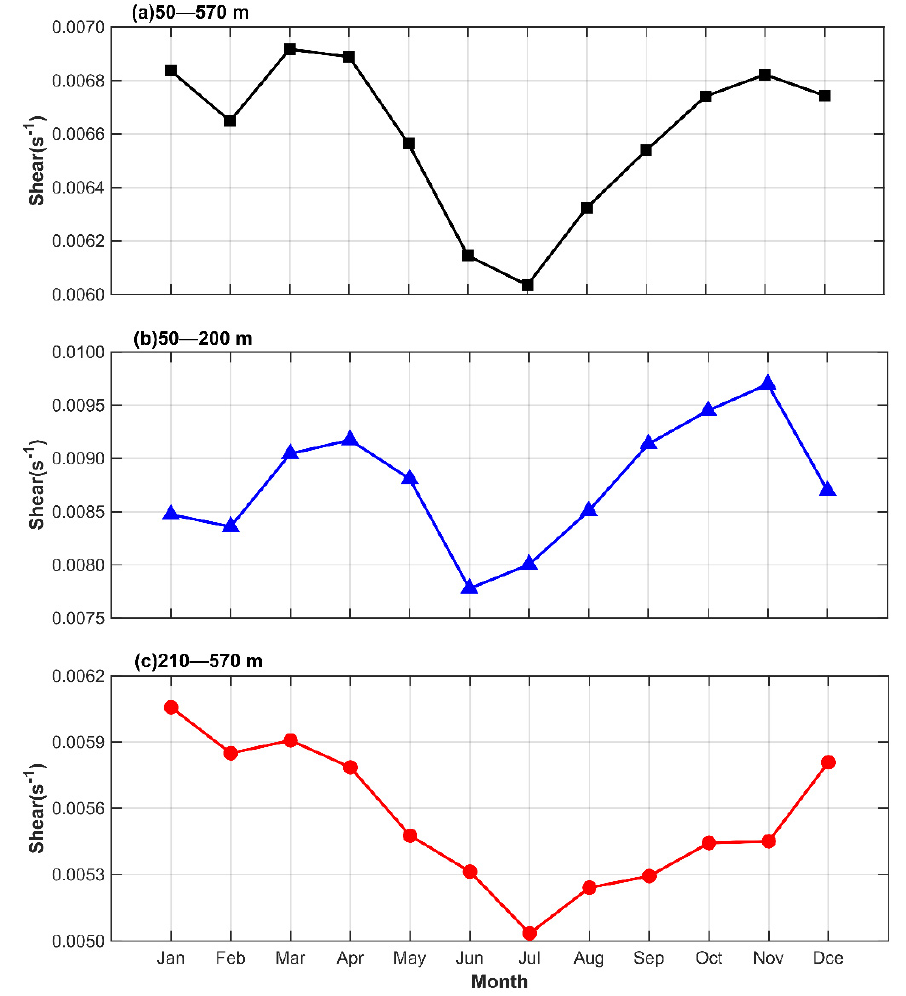
Figure 5. Seasonal evolutions of the depth-averaged total shear. ( a – c ) represent total shear averaged over 50–570 m, 50–200 m, and 210–570 m, respectively.